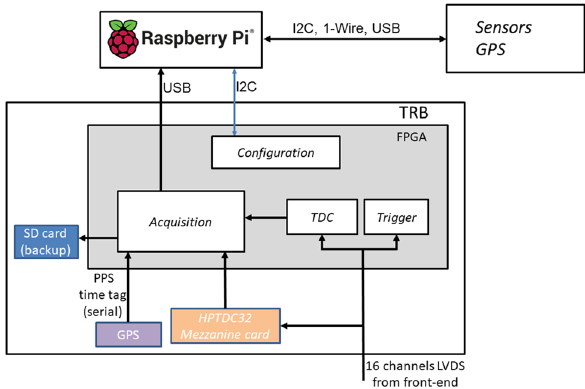
Fig. 4 Read-out DAQ and Control block diagram